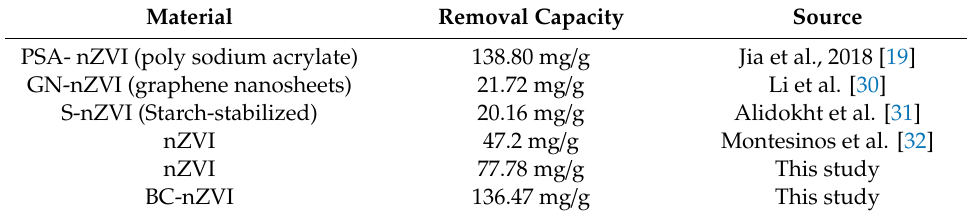
Table 2. Comparison of total Cr removal with di ff erent materials reported in the literature.